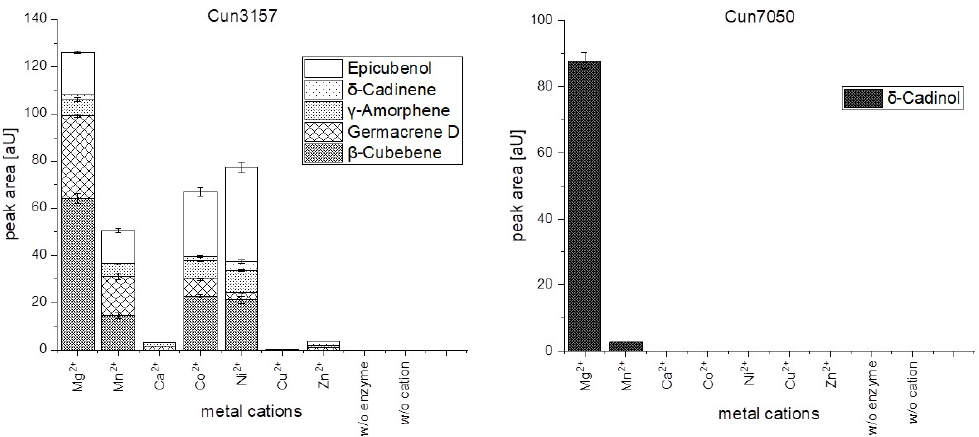
Figure 4. Metal cation dependency of Cun3157 and Cun7050. Peak areas are plotted against the used metal ions. Blank reactions without STS (w/o enzyme) and without any metal ion solution (w/o cation) were used as control reactions.